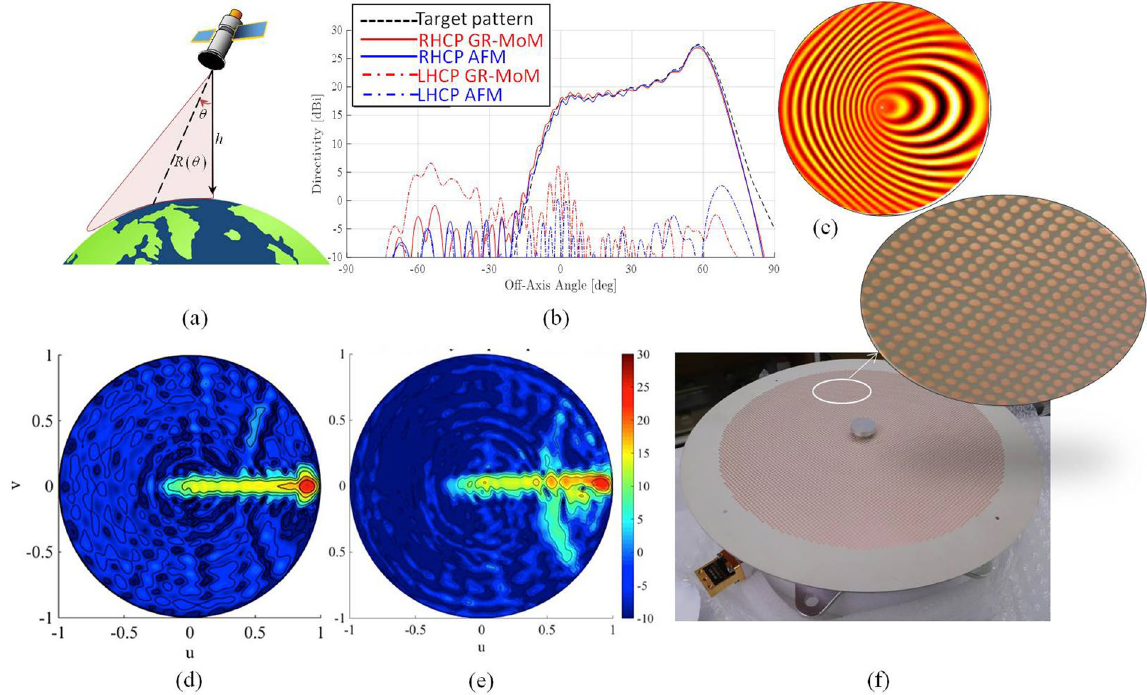
Figure 4. Operative environment, layout and performances of the shaped beam MTS antenna; ( a ) sketch of the Earth surface coverage obtained by using a sectorial isoflux antenna with a turn-table mechanism; ( b ) simulated directivity pattern of a sectorial isoflux MTS antenna for Earth observation missions from LEO satellites; ( c ) sketch of the impedance pattern on the metasurface; ( d ) simulated RHCP component of the directivity for the isoflux sectorial beam antenna in the u-v plane; ( e ) measured RHCP component of directivity for the isoflux sectorial beam antenna in the u-v spectral plane at 26.4 GHz; ( f ) picture of isoflux sectorial beam antenna realization with a detail of the pixelated surface. In the center of the aperture, a metallic cap allows one to improve the antenna matching and the SW launching